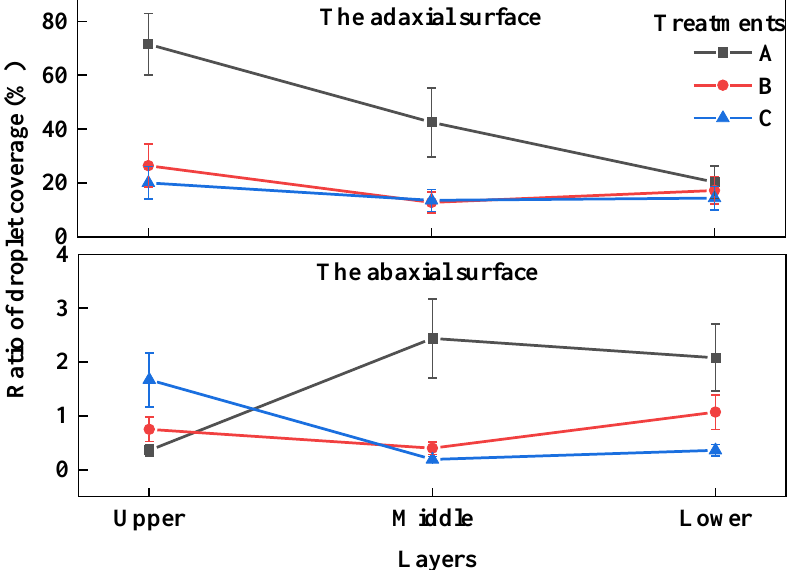
Figure 7. The ratio of droplet coverage distribution using the boom sprayer with the canopy-opening divider combination device.